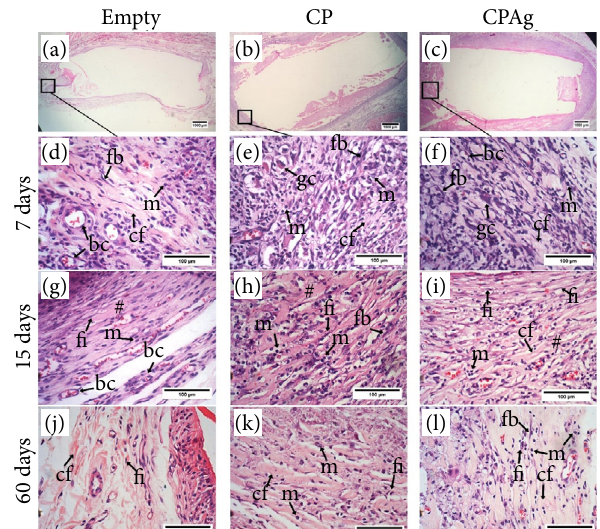
Figure 4 - Photomicrographs show the subcutaneous tissue of the implantation of the materials. The region of the tissue in which the microscopic analyses were performed are demarcated with a square for (a) the empty tube, (b) CP, and (c) CPAg, (d, g, j) represent photomicrographs from the period of 7 days after surgery, (e, h, k) 15 days and (f, i, l) 60 days. At seven days, the tissue reaction evidences the presence of intense inflammatory infiltrate and a dense deposition of collagen fibers (#), the most present cell type were the mononuclear cells (m) for all groups. However, for CP and CPAg, (h and i) the inflammatory